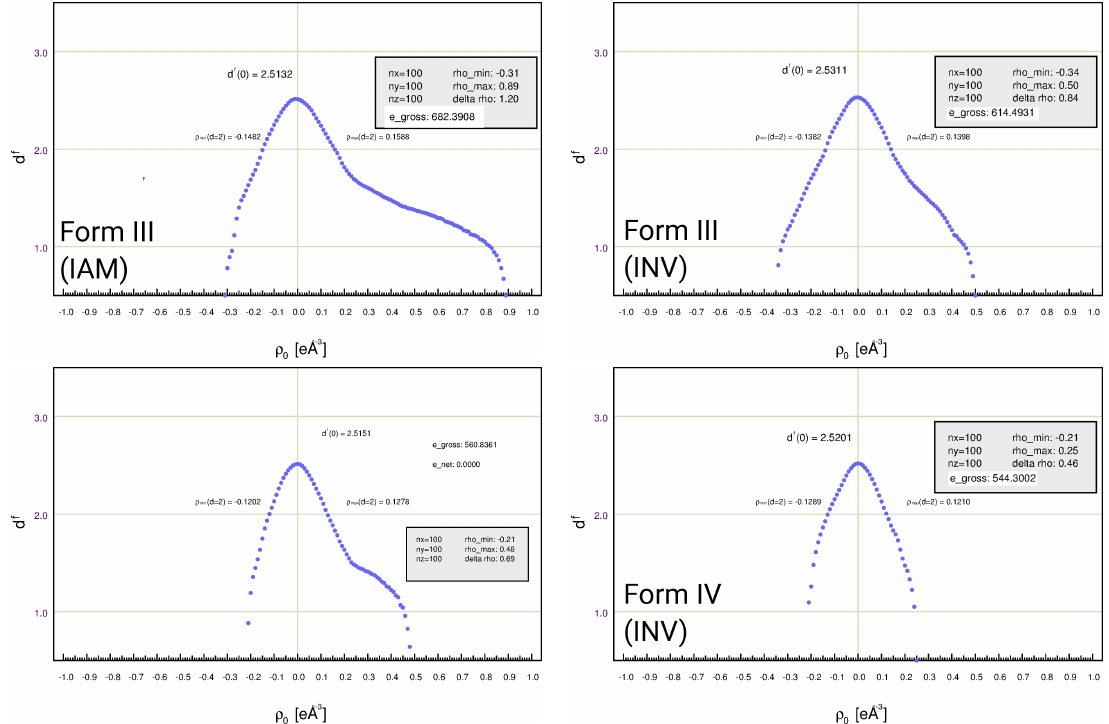
Figure 3. Meindl plot [29] from residual density analysis for the IAM (left) and invariom models (right) for new tetragonal (top) and orthorhombic polymorphs (bottom) of sodium